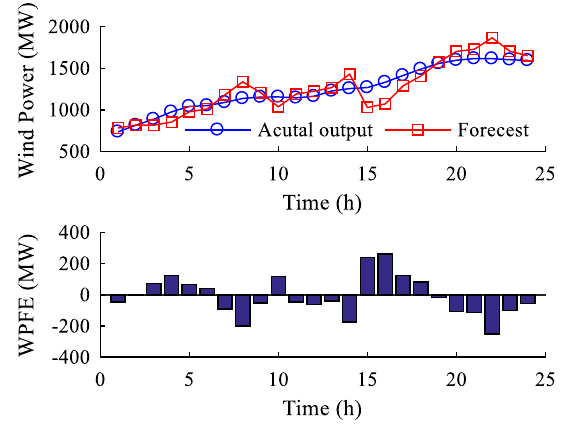
Fig. 1 Power imbalance caused by